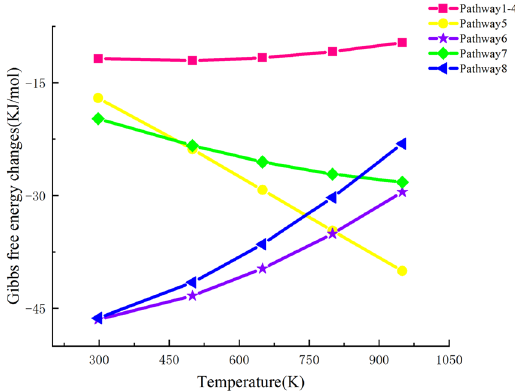
Figure 3. Gibbs free energy Δ G relationship diagram for pathway 1–8.